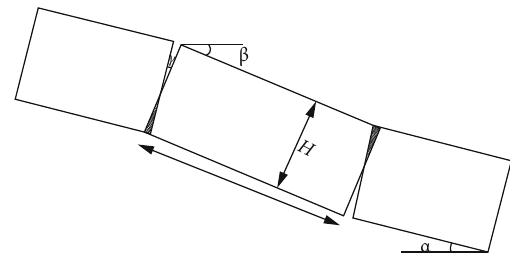
Figure 11: Indication of roof hinged structure.